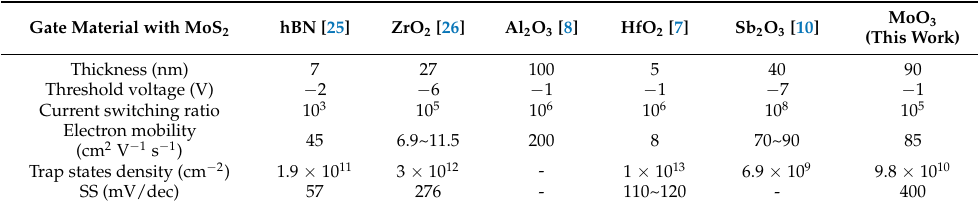
Table 1. Device data for different gate dielectric layers.